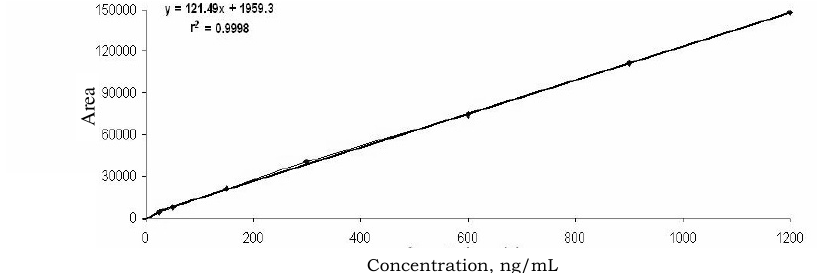
Figure 10. Calibration curve for voglibose (25 η g/mL to 1200 η g/mL)